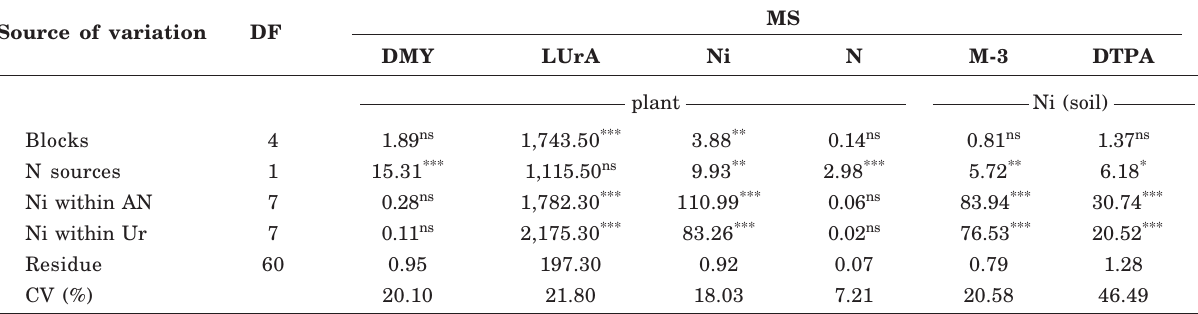
ns , ** and *** : not significant and significant at 1 and 0.1 %, respectively.